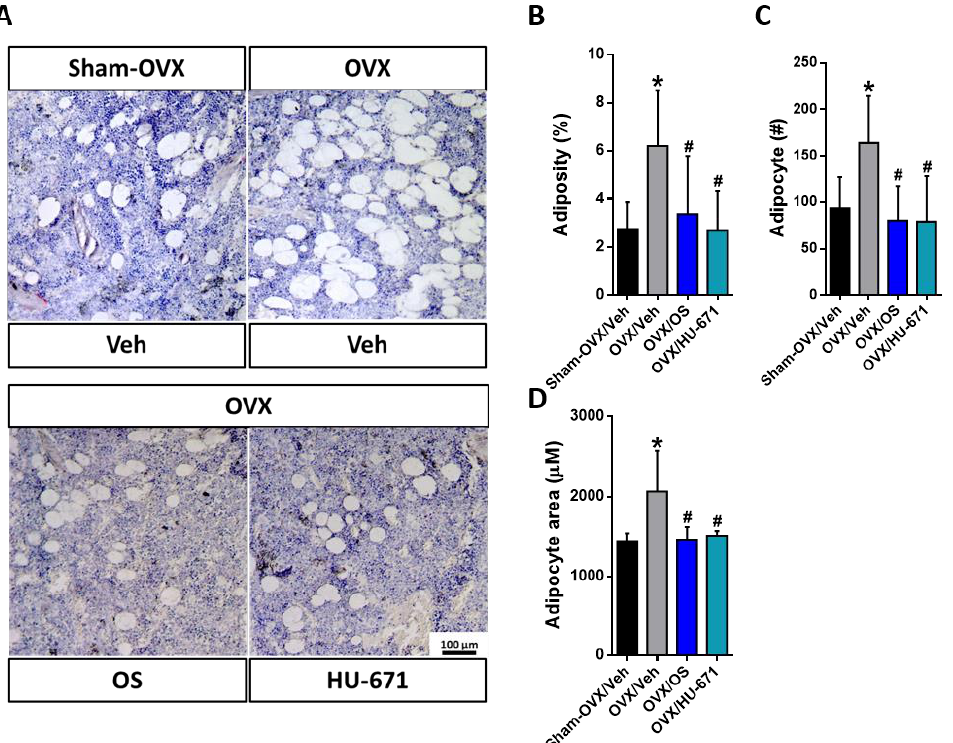
Figure 6. Reversal of bone marrow adiposity by OS and HU-671. Representative images of bone marrow adiposity in H&E stained specimens of control and treatment groups (OS, 3 mg / kg / day; HU-671, 0.5 mg / kg / day; A ), adiposity percentage ( B ), the number of adipocytes ( C ), and adipocyte area ( D ). Data represent the means ± SDs obtained in 5–8 mice per condition. * p < 0.05 versus the Sham-OVX / Veh-treated group, # p < 0.05 versus the OVX / Veh-treated group.